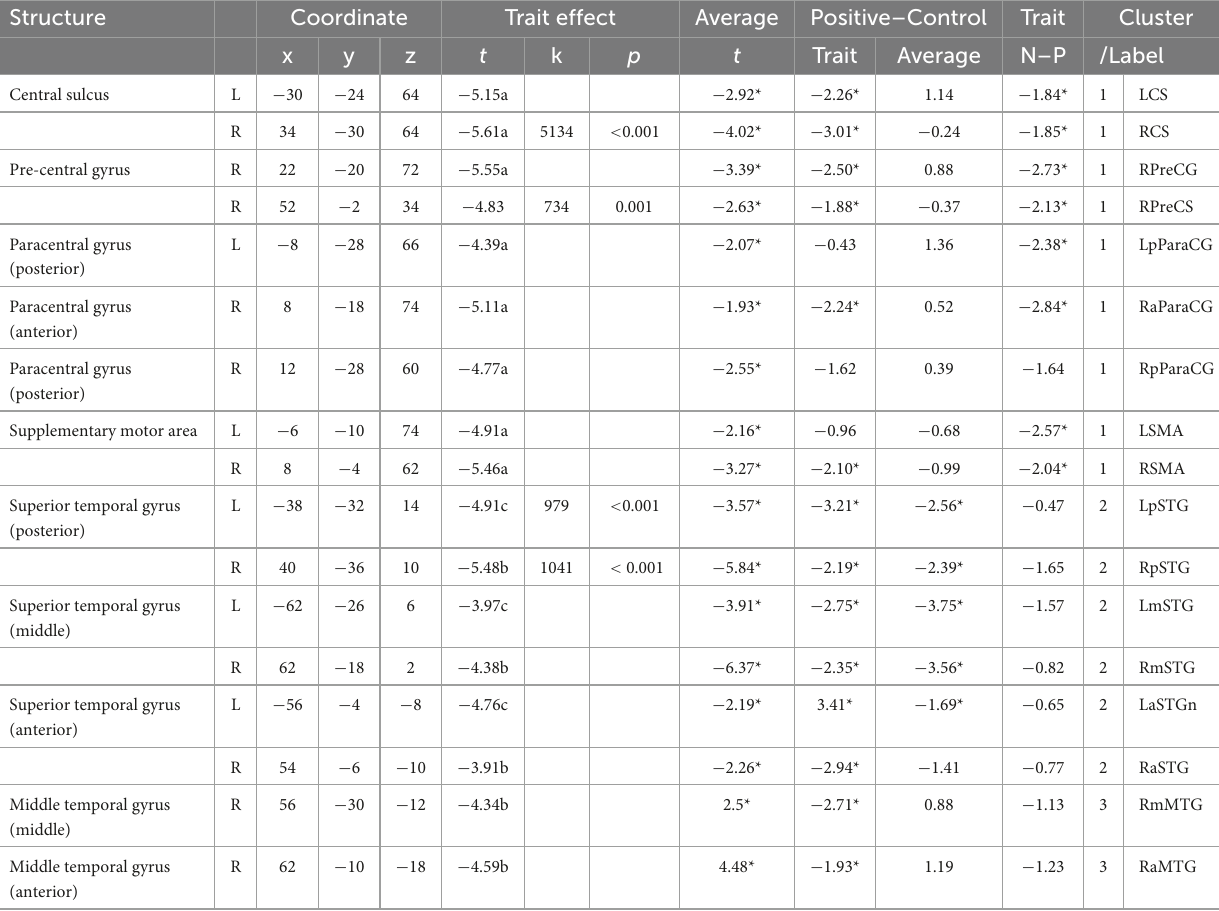
TABLE 1 Neural correlates of the automatic adaptive emotion regulation trait for negative emotional response. Structure Coordinate Trait effect